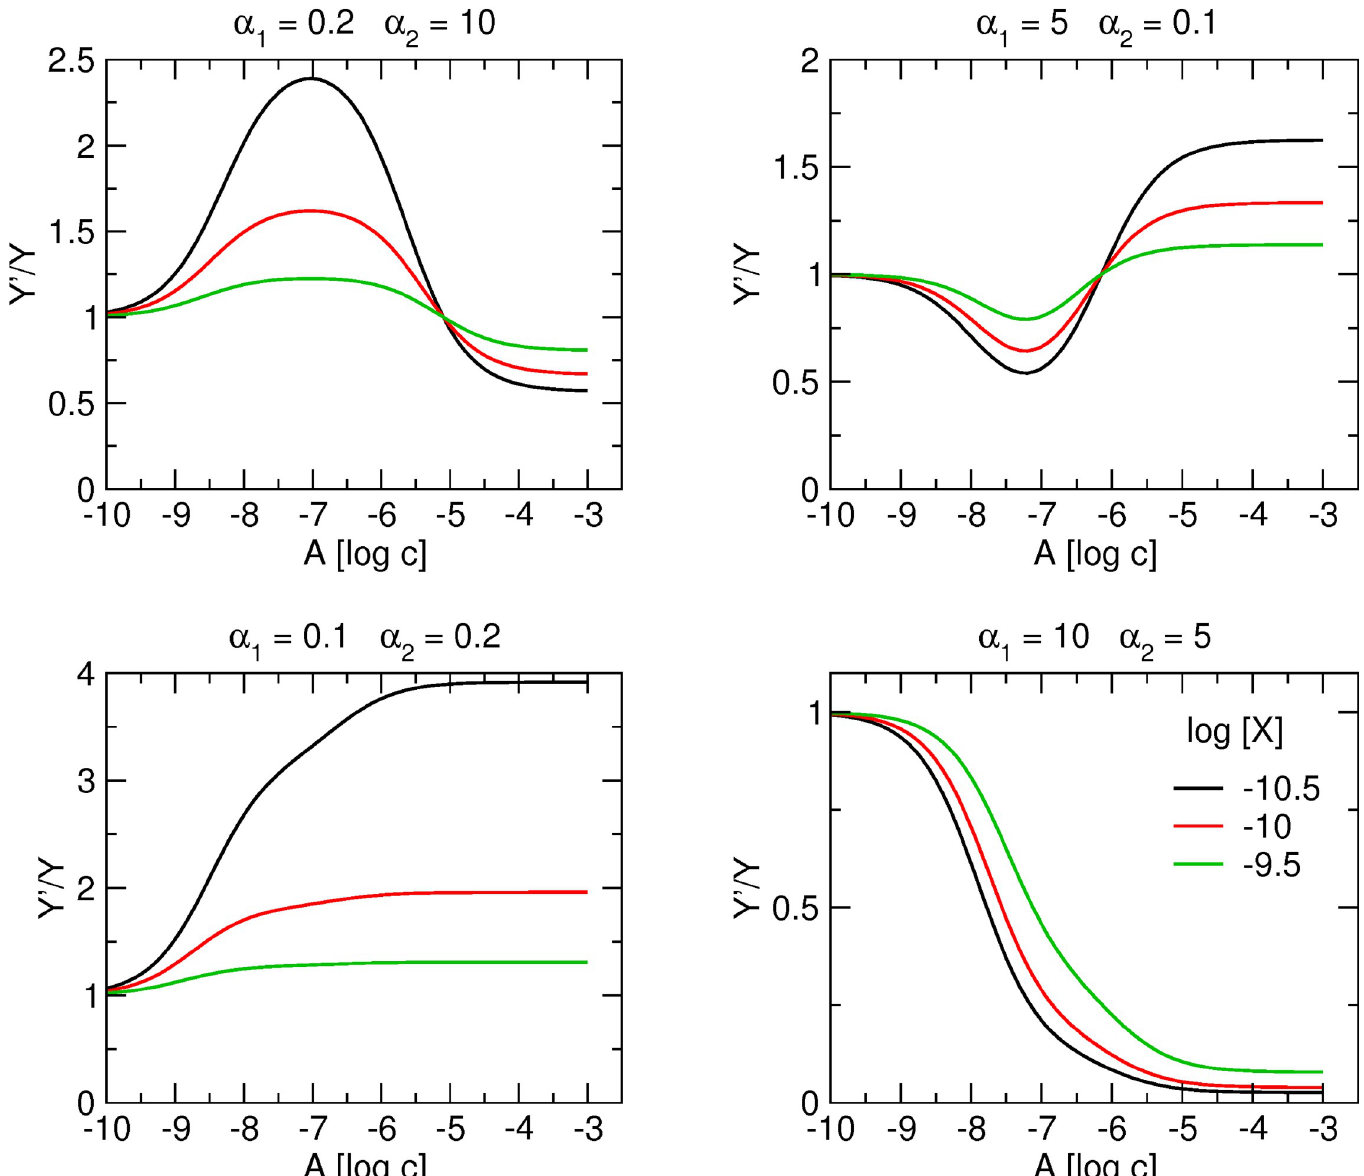
Fig 9. Concentration dependence of binding of allosteric modulator to two allosteric sites. Simulation of tracer binding (ordinate) in the presence an allosteric modulator binding to two allosteric sites for various combinations of positive and negative cooperativity with the tracer indicated at headings of individual plots. Binding of the tracer is expressed as fold over control binding in the absence of allosteric modulator. Abscissa, concentration of allosteric modulator expressed as logarithm of molar concentration. Logarithm of concentration of tracer X is shown in the graph legend. Simulation parameters: K X = 0.1 nM, K A1 = 10 nM, K A2 = 1 μ M, γ = 1, δ = 1.